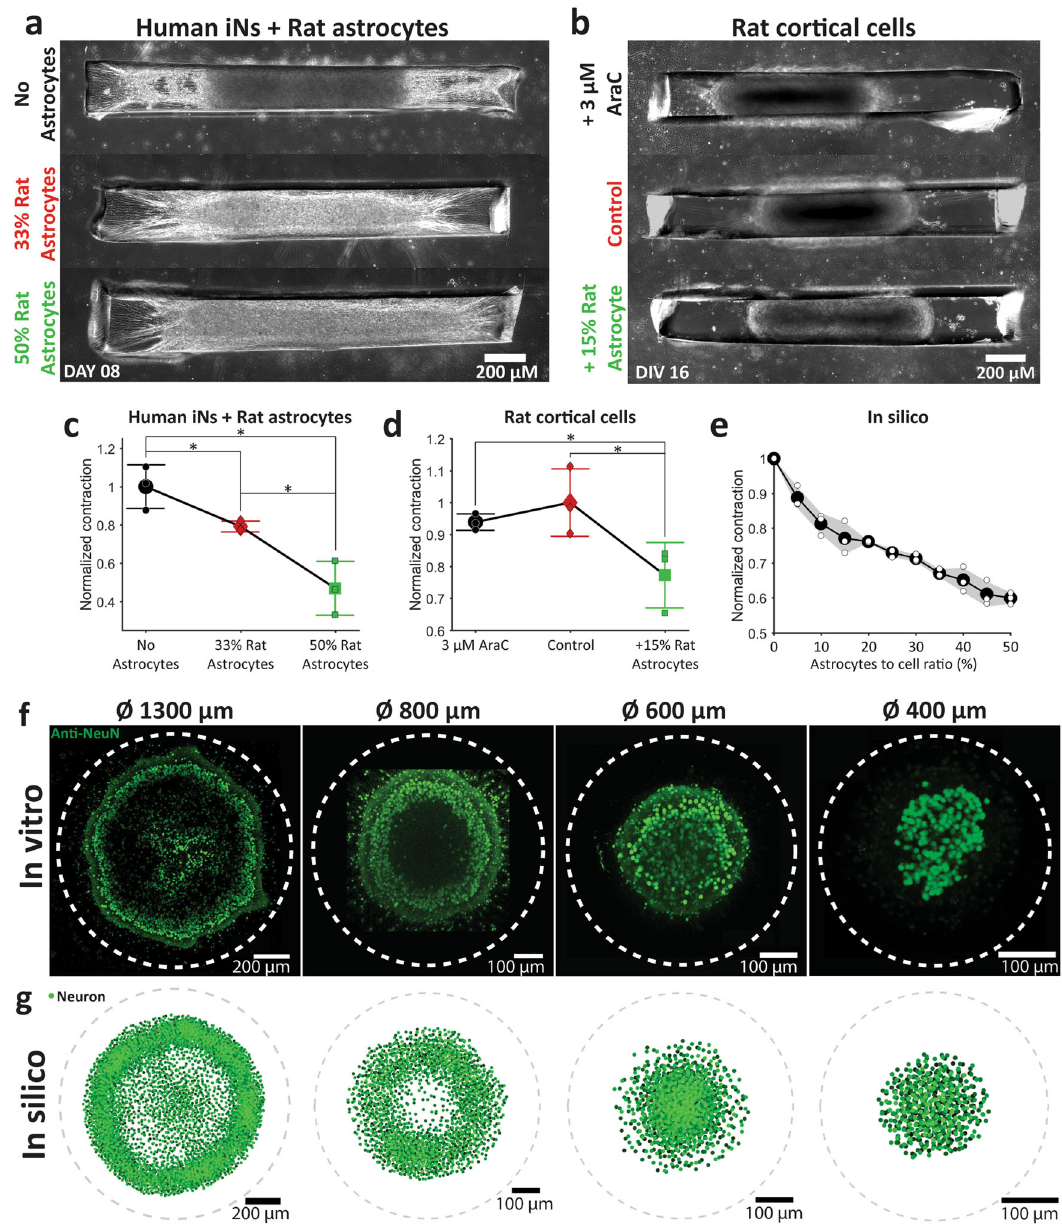
Fig. 8 In silico model validation. a Human iNs cultures with top: no astrocyte, middle: 33% rat astrocytes and bottom: 50% rat astrocytes added. b Rat cultures top: chronically cultured in 3 μ M AraC, middle: control, bottom: + 15% astrocyte added. Mean with standard deviation of normalized contraction for different conditions in c Human iNs + rat astrocyte cultures, d Rat cortical cell cultures, and e in silico culture. Normalization was done fi rst, with respect to culture size on the day 0 and then with respect to c mean of 0% astrocyte culture, d mean of control, e mean of 0% astrocyte culture contraction. Three cultures were analyzed for each condition of each type of culture. Asterisks indicate results of two-sample Kolmogorov – Smirnov test (* p < 0.05, ** p < 0.01, and *** p < 0.001). f Projection of brightest points of all the confocal z -stacks of Anti-NeuN staining of (from left to right) 1300, 800, 600, and 400 μ m diameter rat cortical cell cultures. Dashed lines indicate con fi nement. g In silico simulation results for con fi nement diameter (from left to right) 1300, 800, 600, and 400 μ